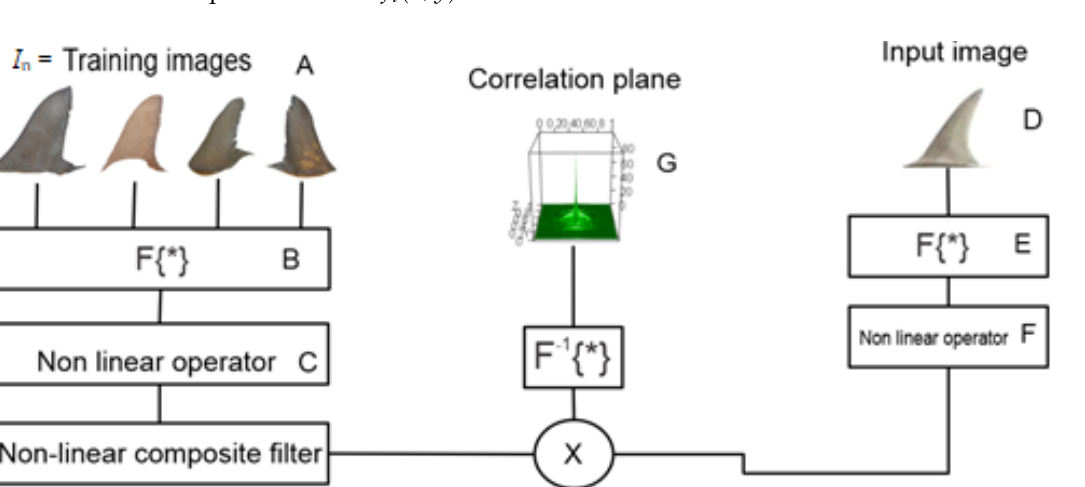
Figure 3. Steps to obtain the non-linear composite filter.